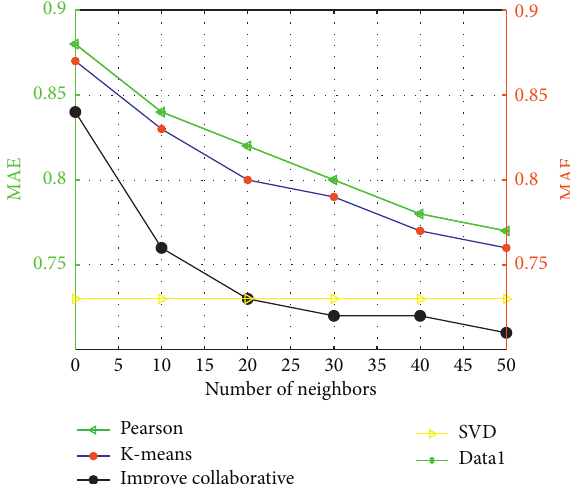
Figure 6: MAE comparison of different collaborative filtering algorithms.